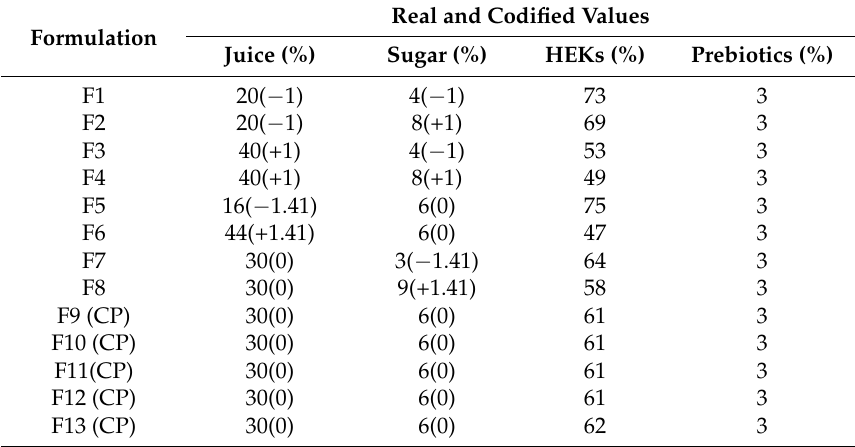
Table 1. Experimental design and ingredients used for the formulation of beverages.